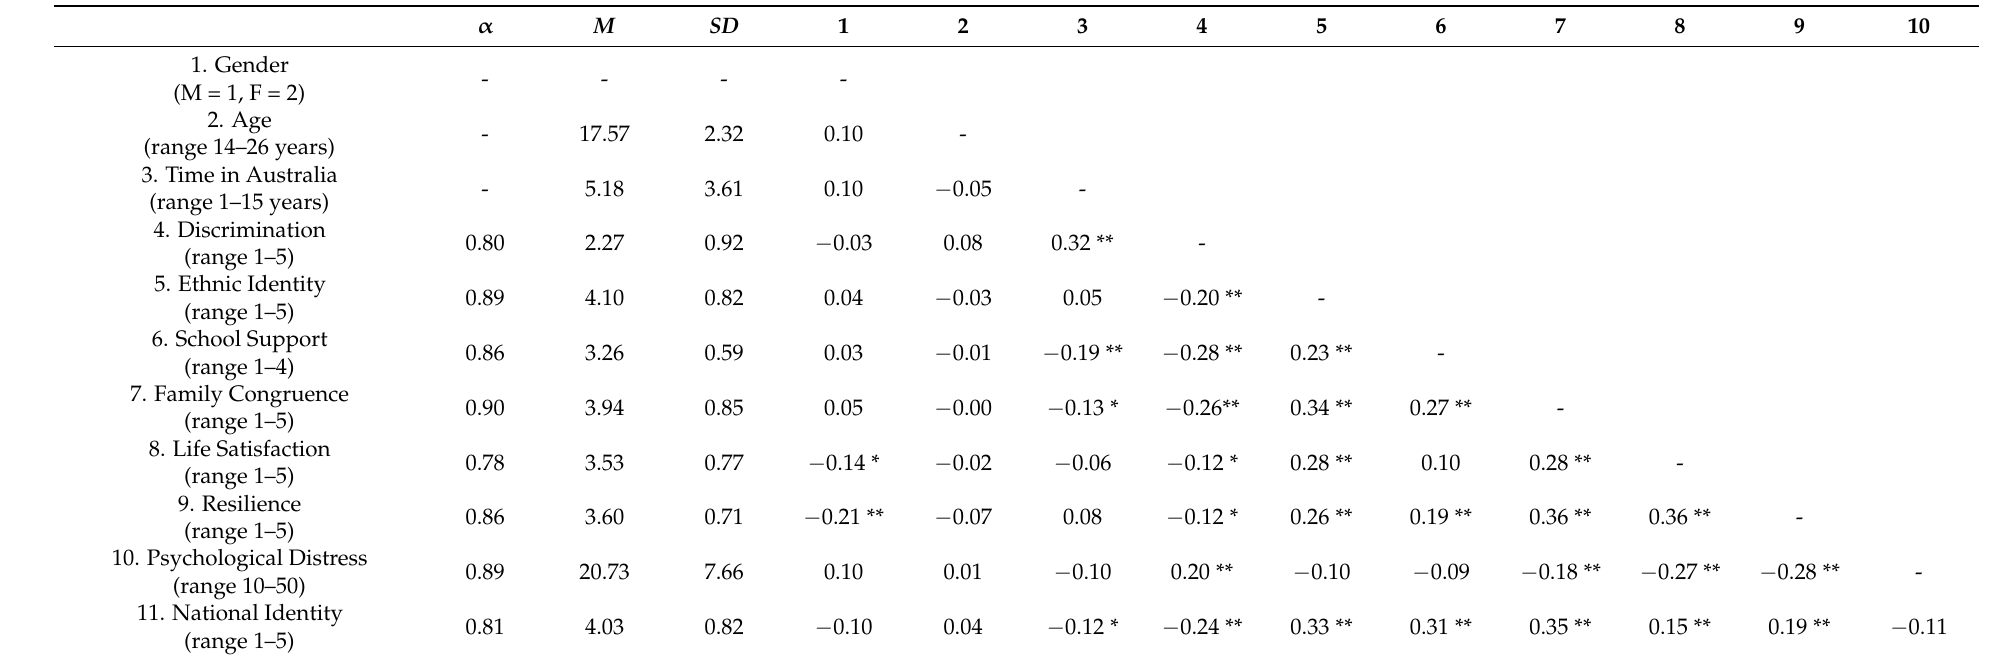
Table 1. Cronbach’s alpha for scales, means and standard deviations, and bivariate